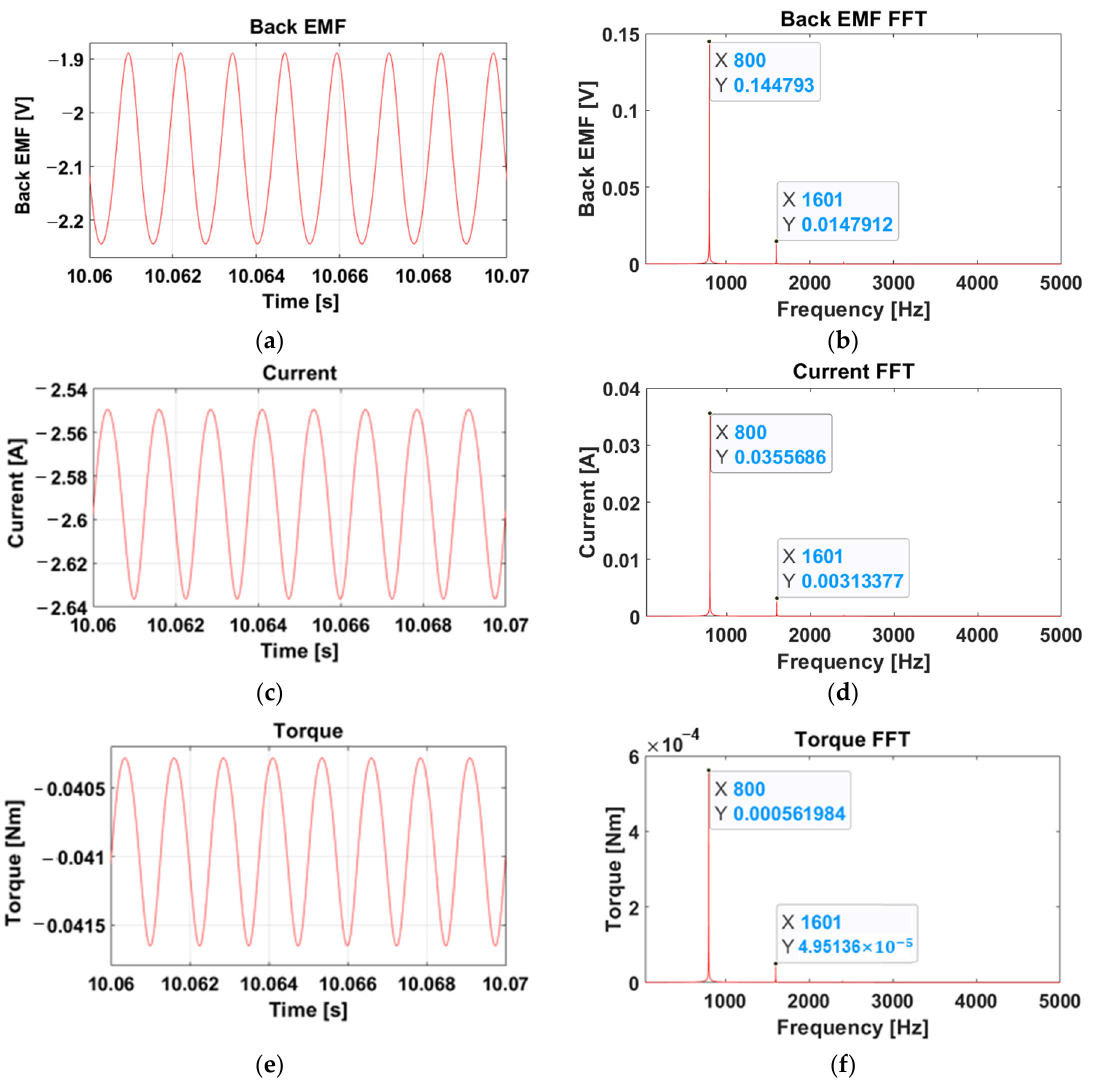
Figure 10. Results of simulation with back EMF including vibration in the CCW: ( a ) Back EMF time data; ( b ) back EMF FFT data; ( c ) current time data; ( d ) current FFT data; ( e ) torque time data; ( f ) torque FFT data. Table 3. Comparison of measured vibration and simulation results at the same voltage.